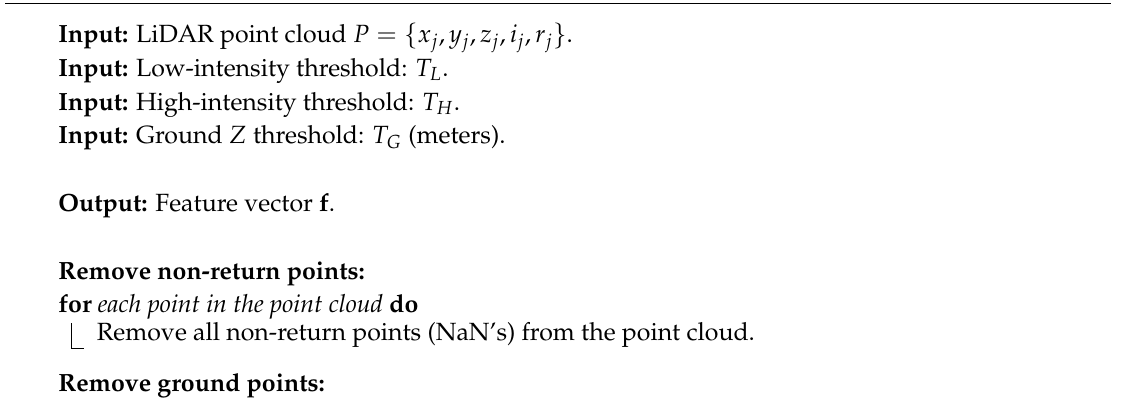
Figure 11. LiDAR detection regions (inner and outer) visualized from a top-down view. Algorithm 2: LiDAR high-level feature extraction